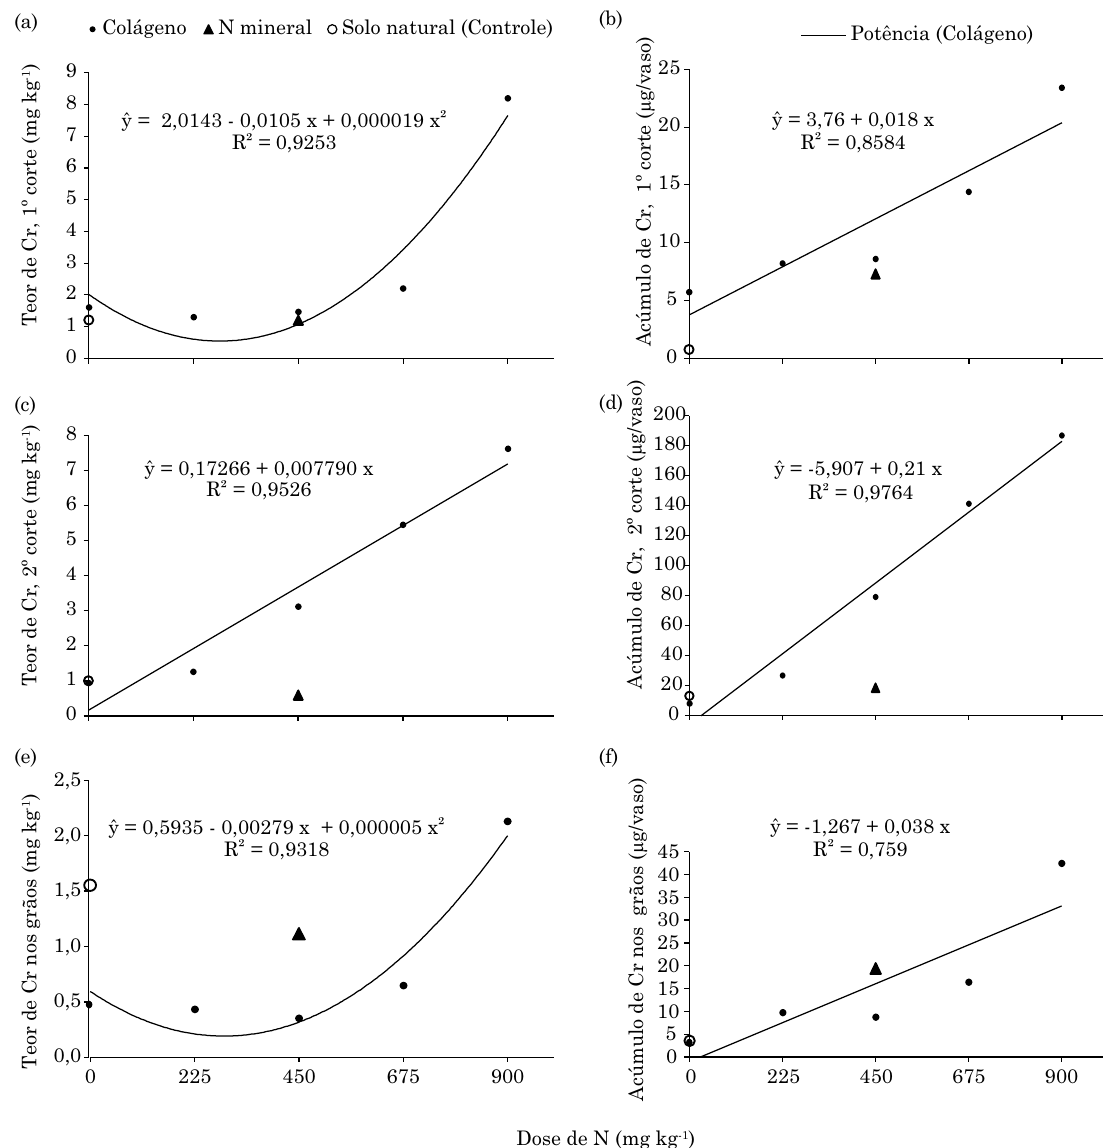
Figura 3. teor e acúmulo de cromo na parte aérea de plantas de trigo no 1º corte (a, b) e no 2º corte (c, d) e nos grãos (e, f), submetidas a doses de nitrogênio via colágeno de curtume e dois tratamentos adicionais, cultivadas em Latossolo Vermelho Distrófico